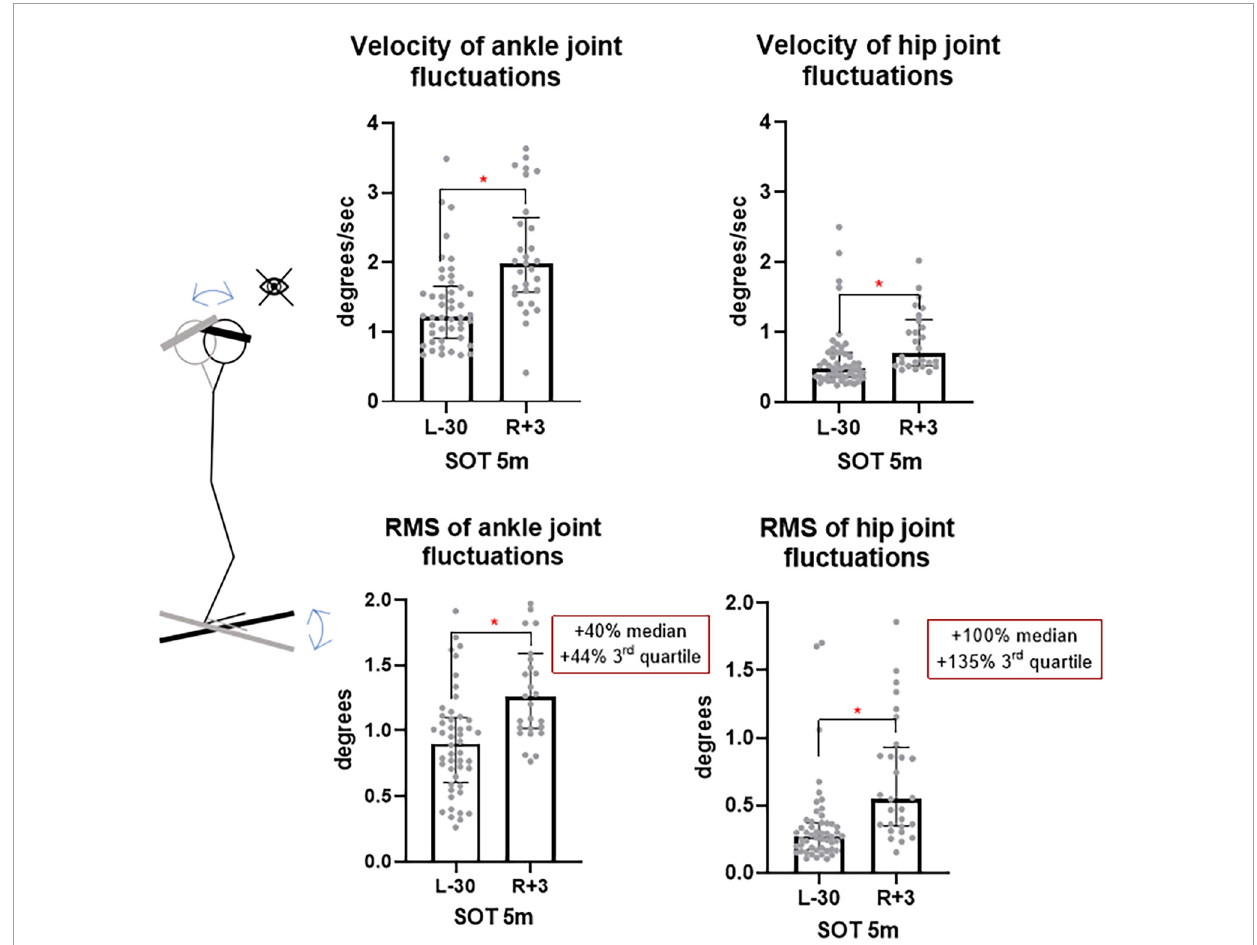
FIGURE11 Ankle and hip joints fluctuation velocity and RMS is SOT5m test. L-30 – 30 days before launch, R + 3 – 3rd day of recovery period after landing.